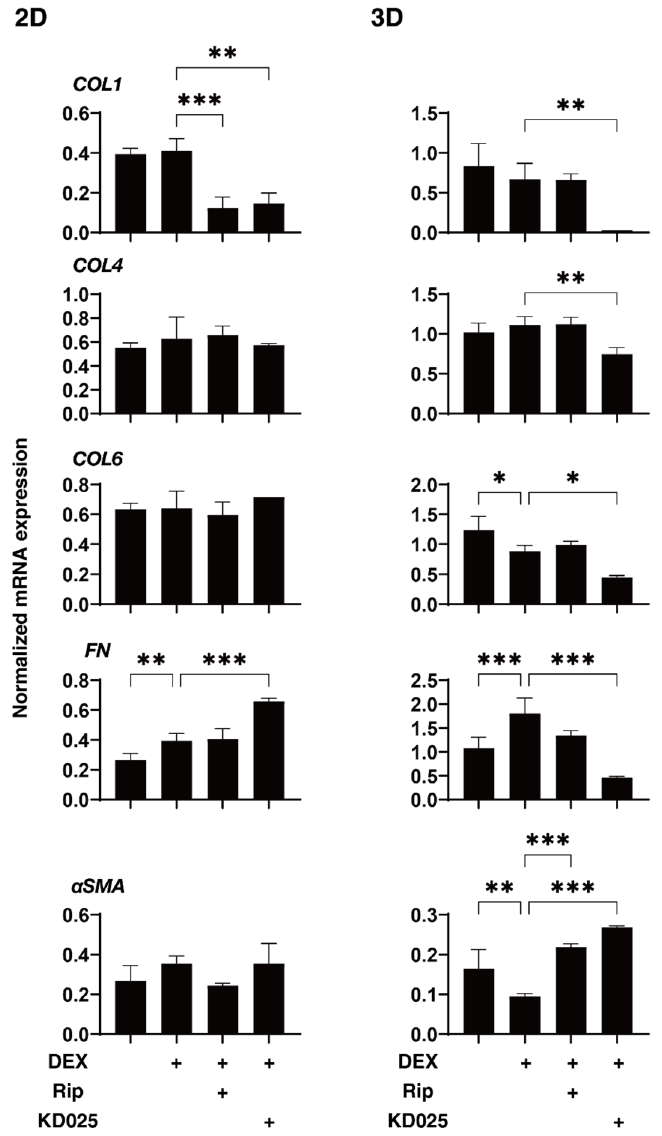
Figure 4. mRNA expression of ECM molecules in 2D- and 3D-cultured HTM cells. On Day 6, HTM 2D cells and 3D spheroids (non-treated control; NT) and those treated with 250 nM DEX in the absence or presence of 10 µM ripasudil (Rip) or KD025 were subjected to qPCR analysis to estimate